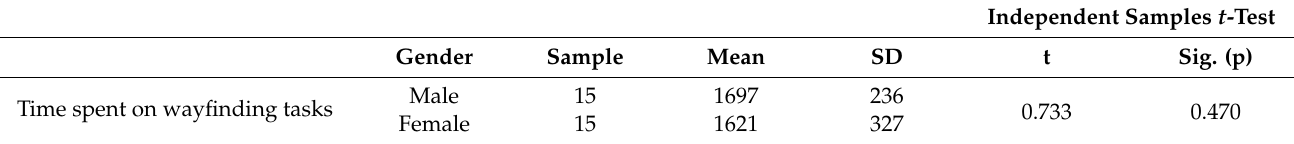
Table 6. Statistics and t -test results of the time spent on the wayfinding tasks by different genders.